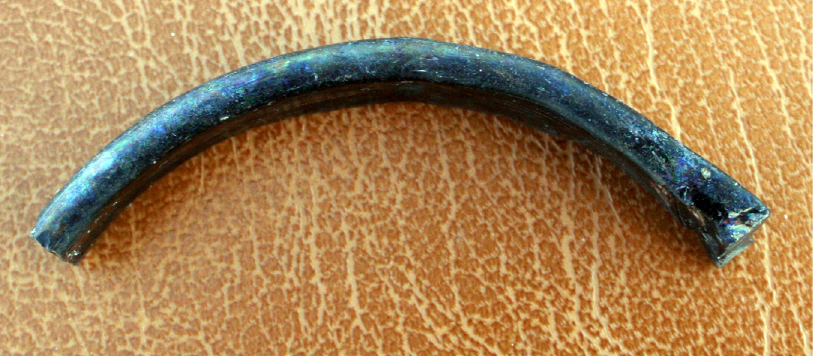
Figure 12. Bronze rings of Middle Byzantine period from the excavation in 2015 (archive of the Ephorate of Antiquities at Kilkis, photo Stamatis Chatzitoulousis).